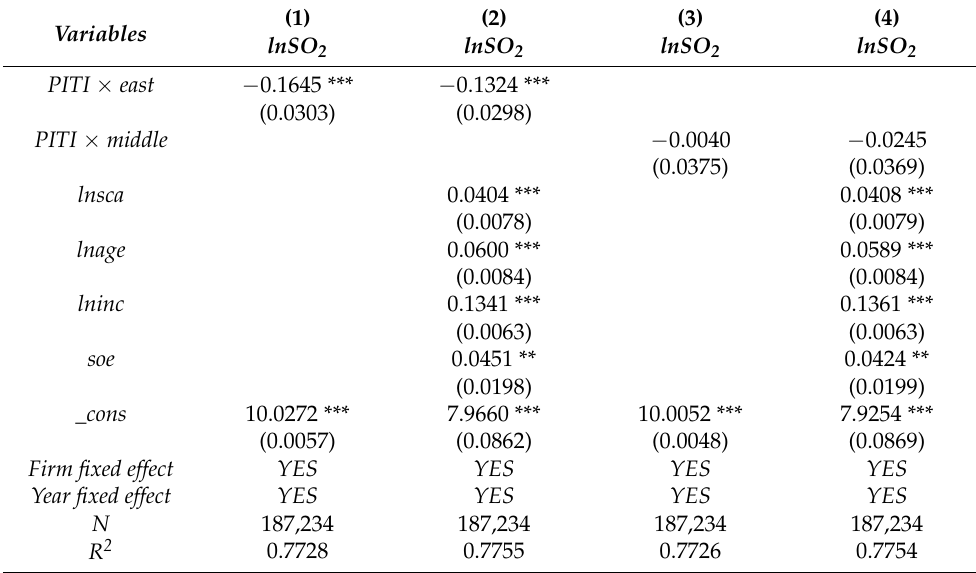
Table 6. The test of regional